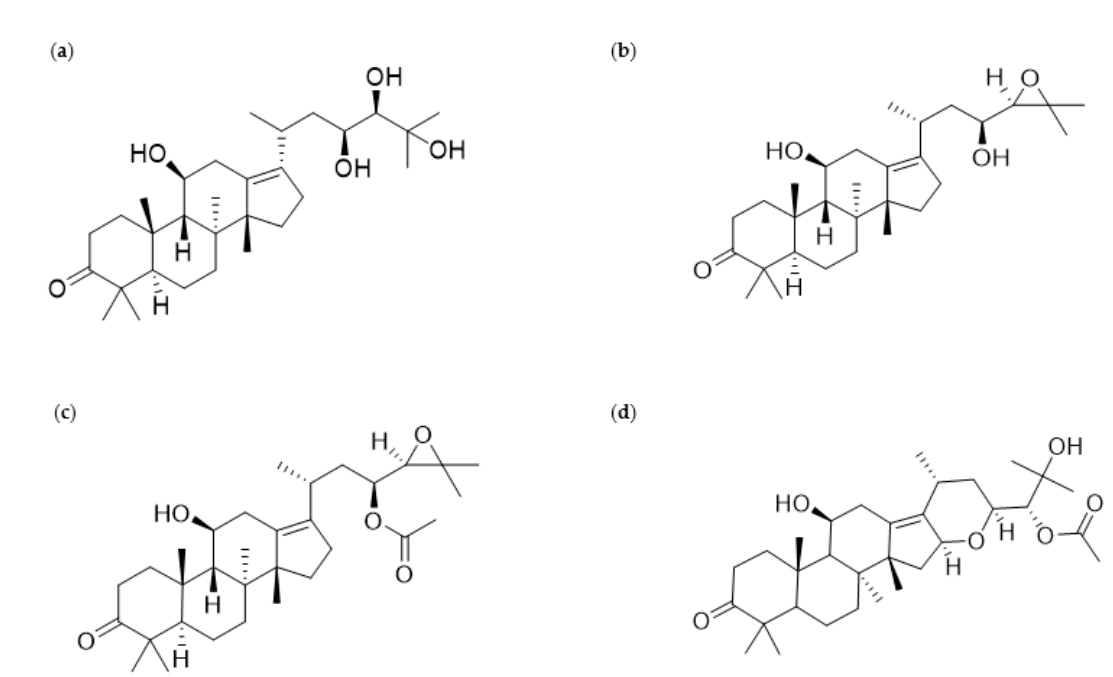
Figure 1. Chemical structures of alisol A (AA), alisol B (AB), alisol B 23-acetate (AB23A), and alisol F 24-acetate (AF24A), which belong to triterpenes isolated from Alismatis rhizome ( AR ): ( a ) AA (PubChem a compound identifier (CID): 15558616, C 30 H 50 O 5, molecular mass 490.7 g/mol), ( b ) AB (PubChem CID: 15558620, C 30 H 48 O 4, molecular mass 472.7 g/mol), ( c ) AB23A (PubChem CID: 14036811, C 32 H 50 O 5, molecular mass 514.7 g/mol), ( d ) AF24A (PubChem CID: 76310823, C 32 H 50 O 6, molecular mass 530.7 g/mol).